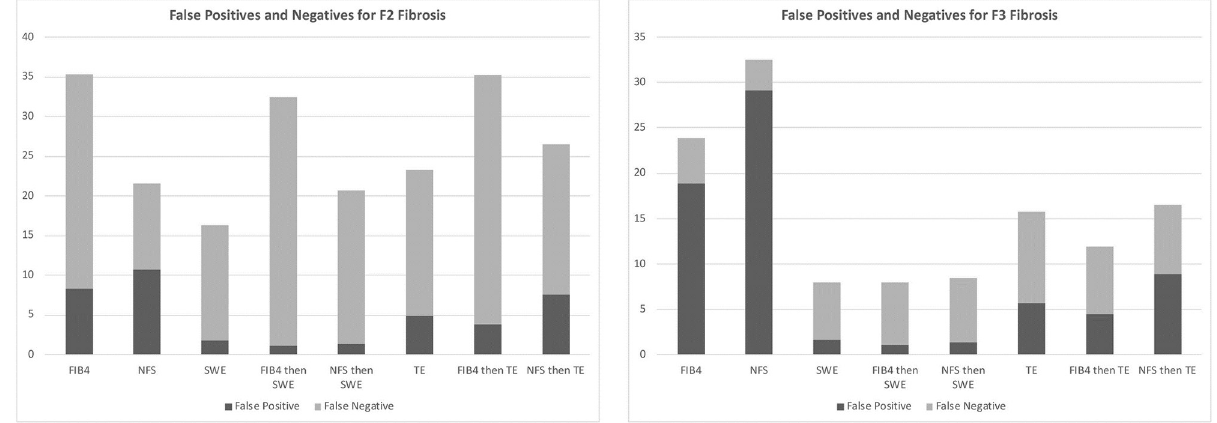
Fig 1. Classification of incorrect diagnoses by risk stratification strategy. Stratification of incorrect diagnoses based on risk strategies. False positive is considered as being an unnecessary referral for a patient without significant/advanced fibrosis while a false negative was a patient with significant/ advanced fibrosis that was not referred to a